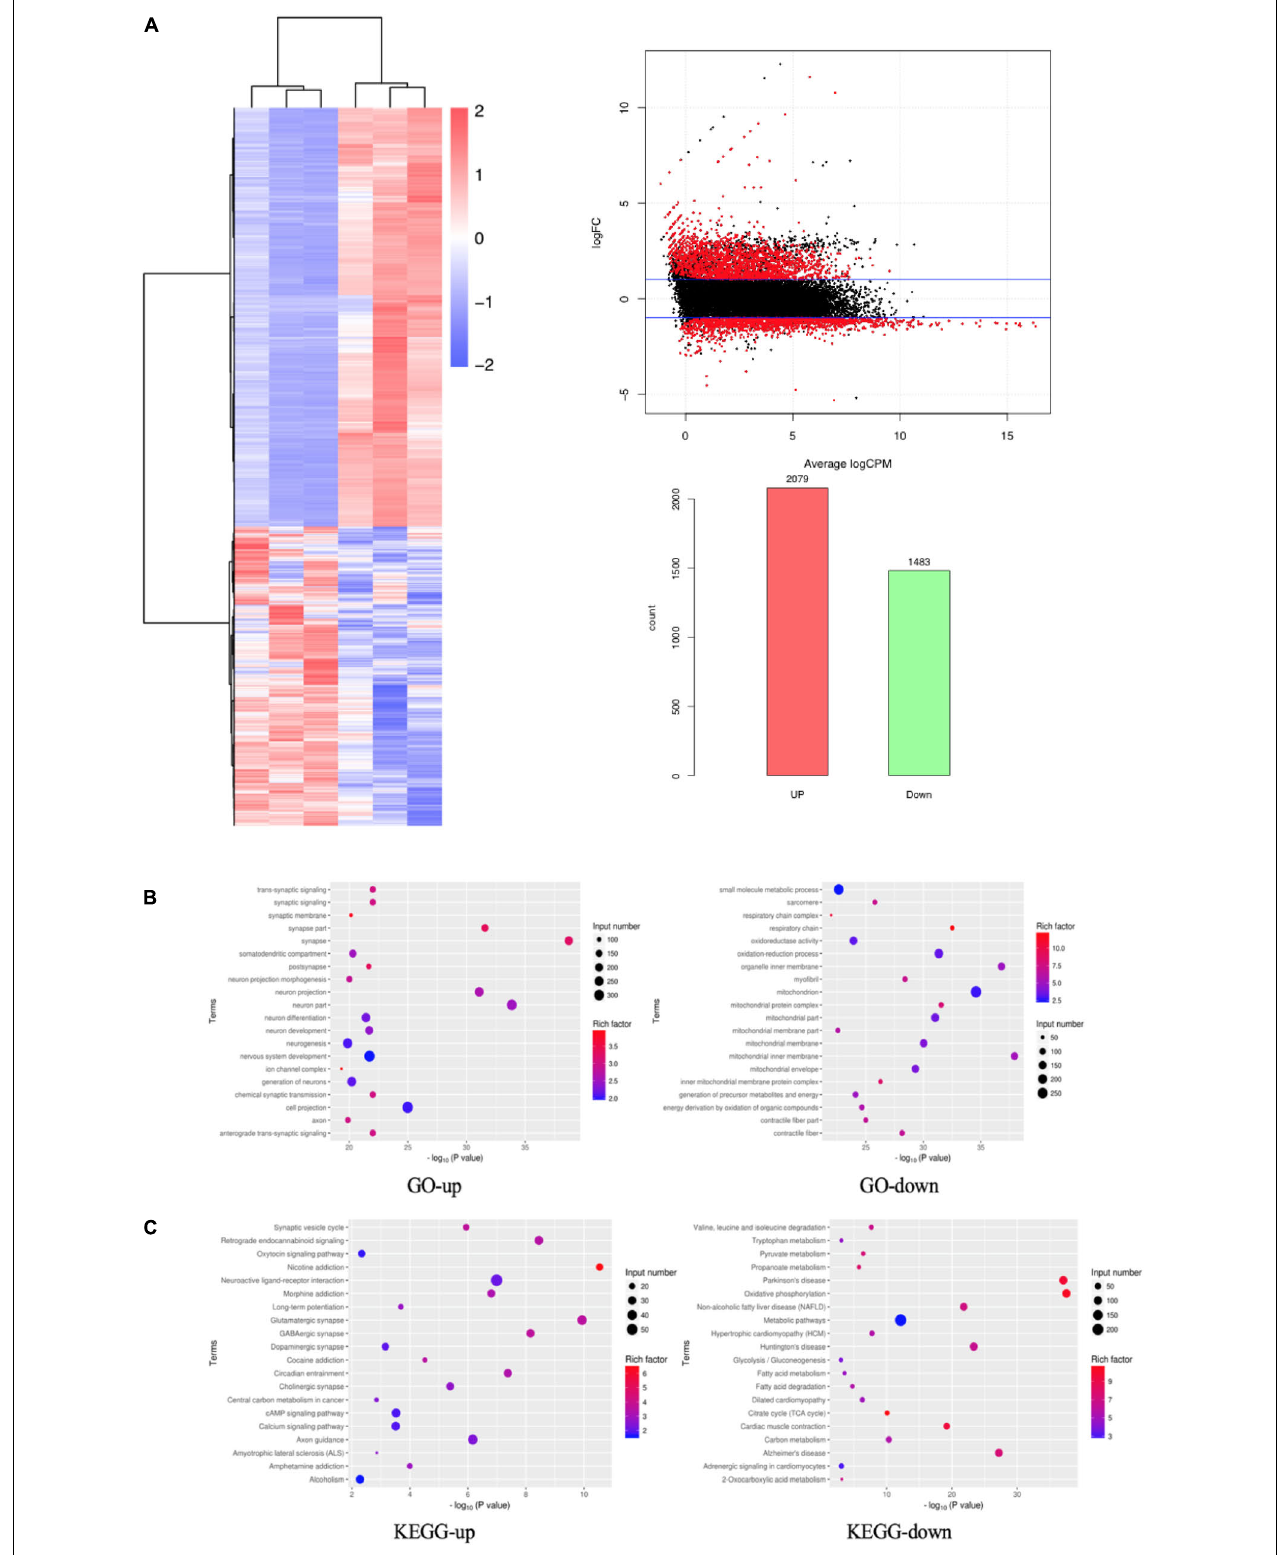
FIGURE 4 | DEGs based on RNA-Seq. (A) DEGs shown in a heat map, MA Plot of DEGs and Statistics of DEGs Up-Down; (B) GO enrichment map of up- and down-regulated genes; (C) KEGG enrichment map of up- and down-regulated genes.